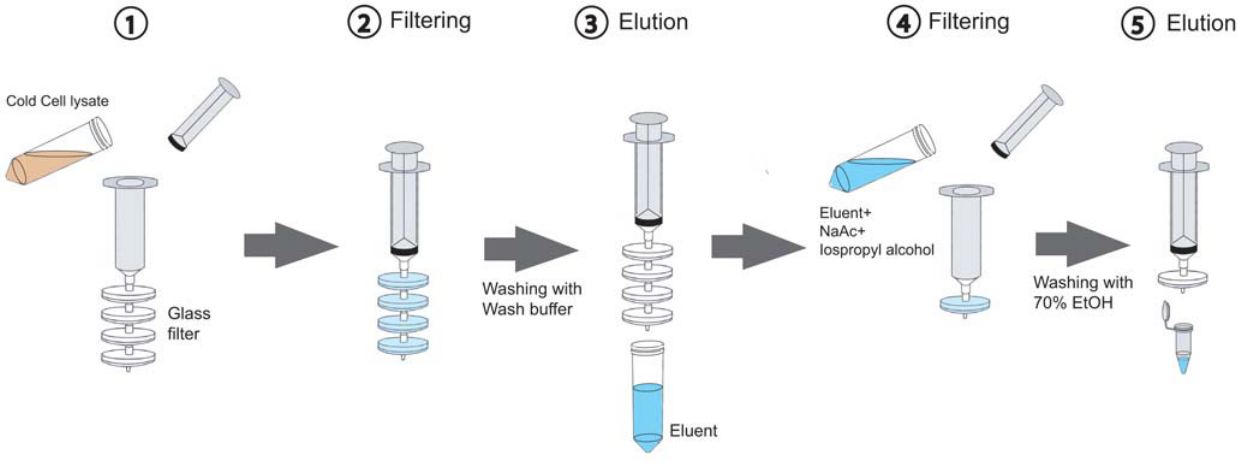
Figure 1. Procedure for plasmid purification using glass syringe filters. Plasmid in the cleared lysate was bound to glass syringe filters. The filters were washed with 20 ml of wash buffer and the bound plasmid was eluted with 20 ml of TE (pH 8.0). The eluent was mixed with 3 ml of sodium acetate (pH 5.1) and 23 ml of ice-cold isopropyl alcohol. The mixture was filtered through a glass filter, the filter washed with 20 ml of 70% ethanol, dried with air and bound DNA eluted with 1 ml of TE (pH 8.0).